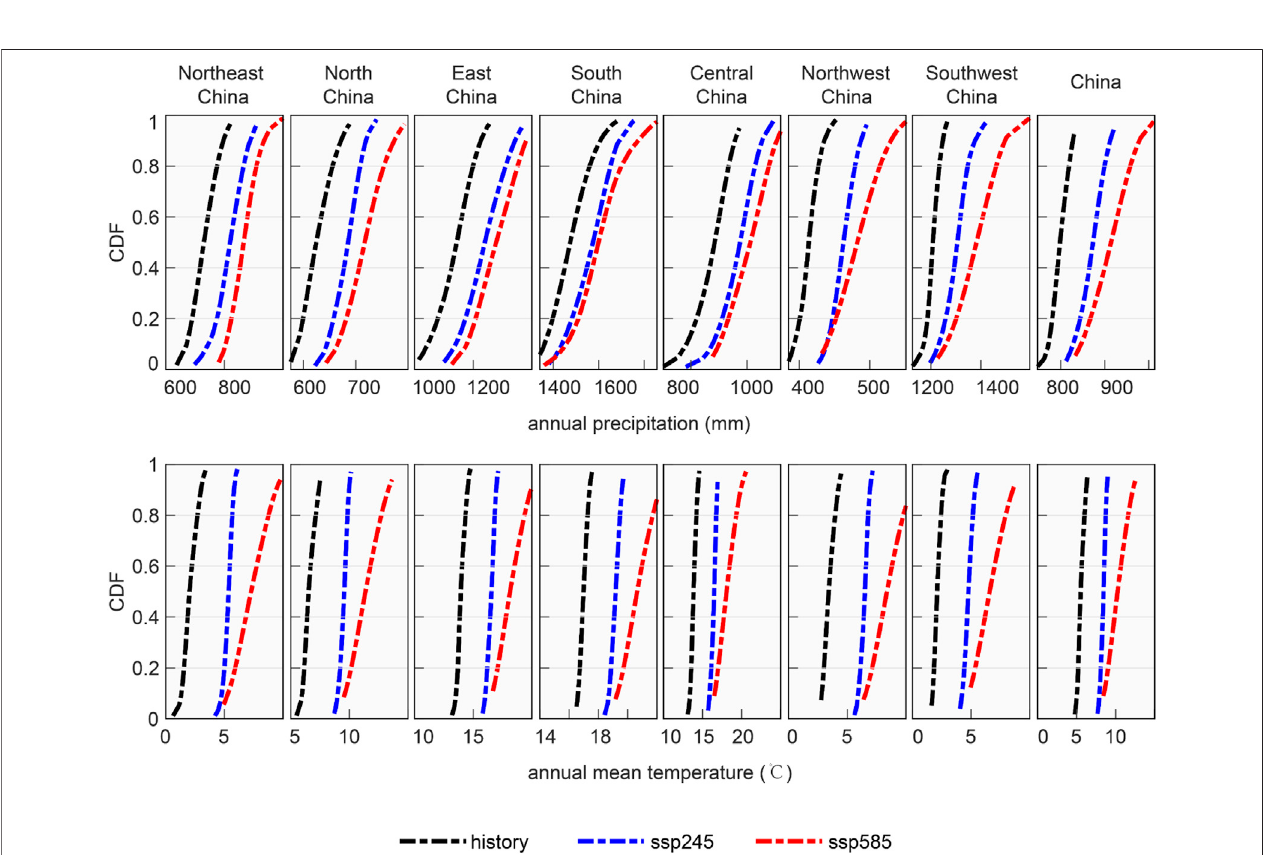
FIGURE 6 | Changes in probability distribution of annual precipitation and the annual mean temperature in China and its seven regions in the historical and future periods.